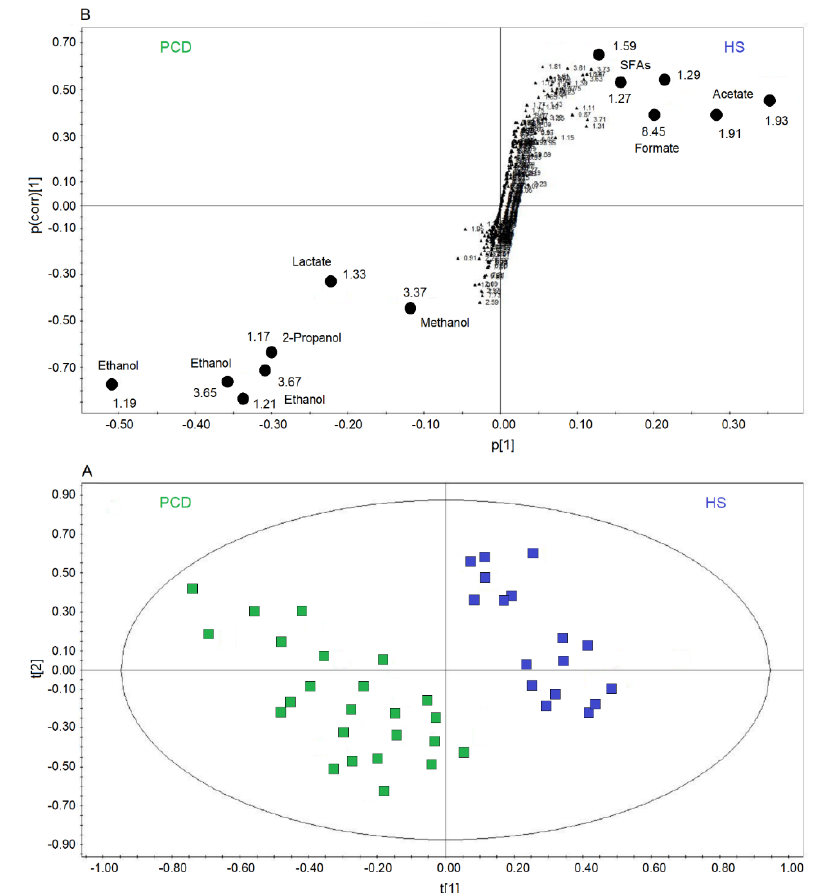
Figure 4. Orthogonal projections to latent structures discriminant analysis (OPLS-DA) of EBC samples for the PCD bronchiectasis and HS comparison. ( A ) Scores plot showing the degree of separation of the model between PCD (green squares) and HS (blue squares). The model presents strong regression (95%, p < 0.0001) and high-quality parameters (R 2 = 84.18% and Q 2 = 83.63%). ( B ) S-plot reporting the chemical shift of the discriminating buckets in the PCD-HS model. Numbers refer to the chemical shift of buckets, and black dots label class discriminating buckets.